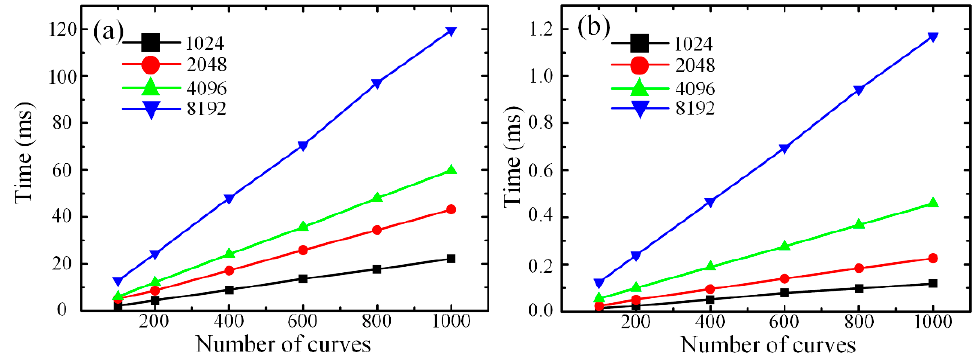
Figure 14. The time contrast of FFT processing on CPU and GPU: ( a ) the time spent on CPU ( b ) the time spent on GPU.